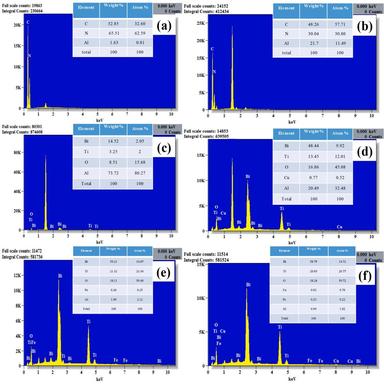
EDS spectra of the (a) g-C3N4, (b) EG-g-C3N4 (c) Bi2Ti2O7, (d) Cu-Bi2Ti2O7, (e) Fe-Bi2Ti2O7, and (f) Cu, Fe-Bi2Ti2O7.